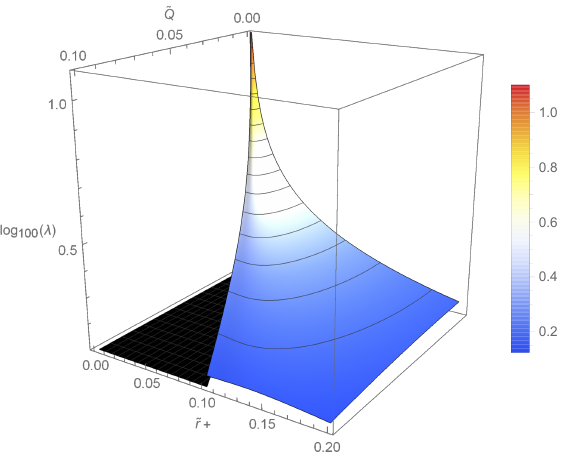
λ as a function of ˜ Q and ˜ r + for unstable null circular 100